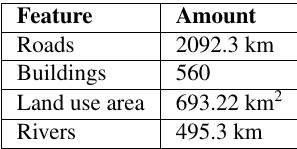
Table 3. Mapping results of the second course meeting. Source: resultmaps.neis-one.org/, https://mapathon.cartong.org/